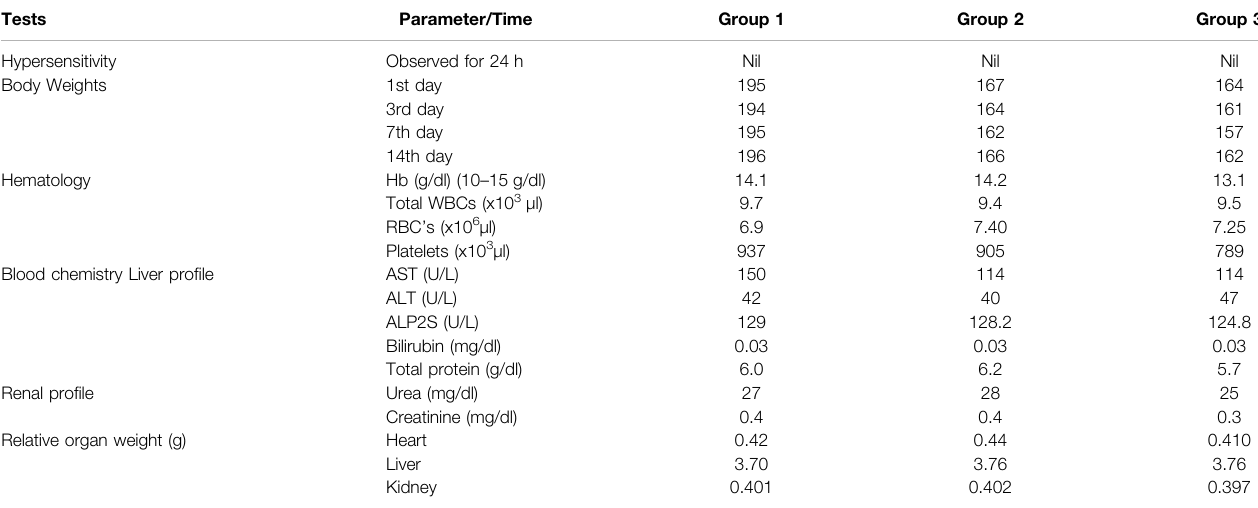
TABLE 4 | Body weight, Hematology, Blood chemistry, and Relative organ weight of albino